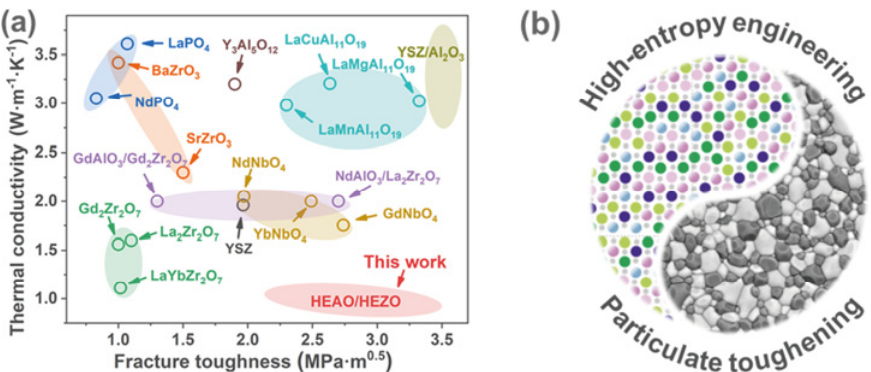
Fig. 8 (a) Thermal conductivity and fracture toughness of some selected TBC materials and (b) synergistic effect demonstrated in the HEAO-based particulate